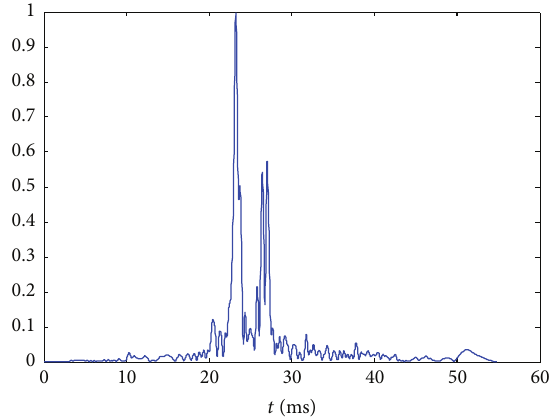
Figure 8: Impulses response of tank